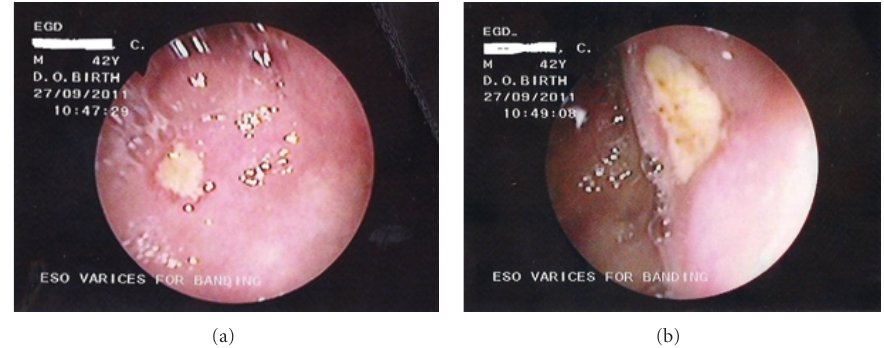
Figure 2: (a) Endoscopic view of the duodenum showing the ulcer on its anterior wall. (b) Endoscopic view of duodenum showing the ulcer on its posterior